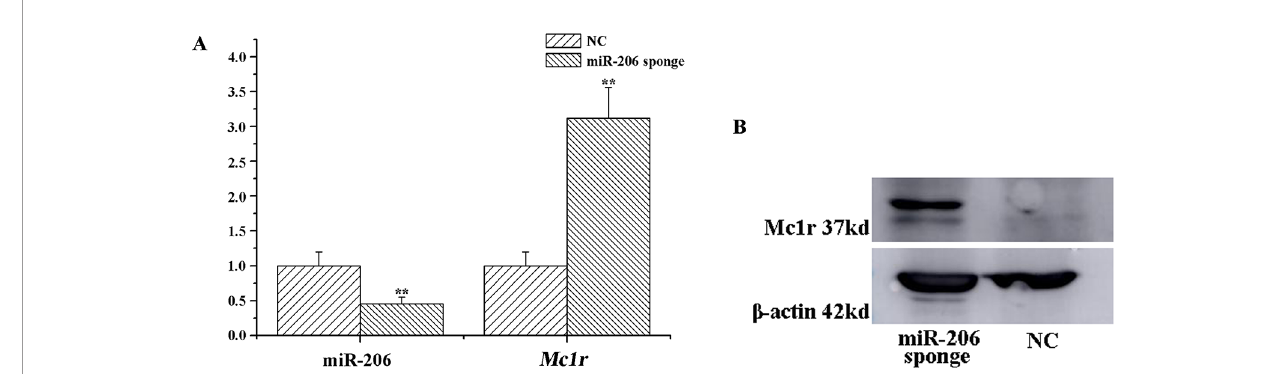
FIGURE 6 | MiR-206 sponge promotes melanocytes proliferation. (A) Expression levels of miR-206 and Mc1r mRNA were determined by QRT-PCR after lentivirus transduction (** P < 0.01). (B) Western blot analysis of Mc1r protein content.